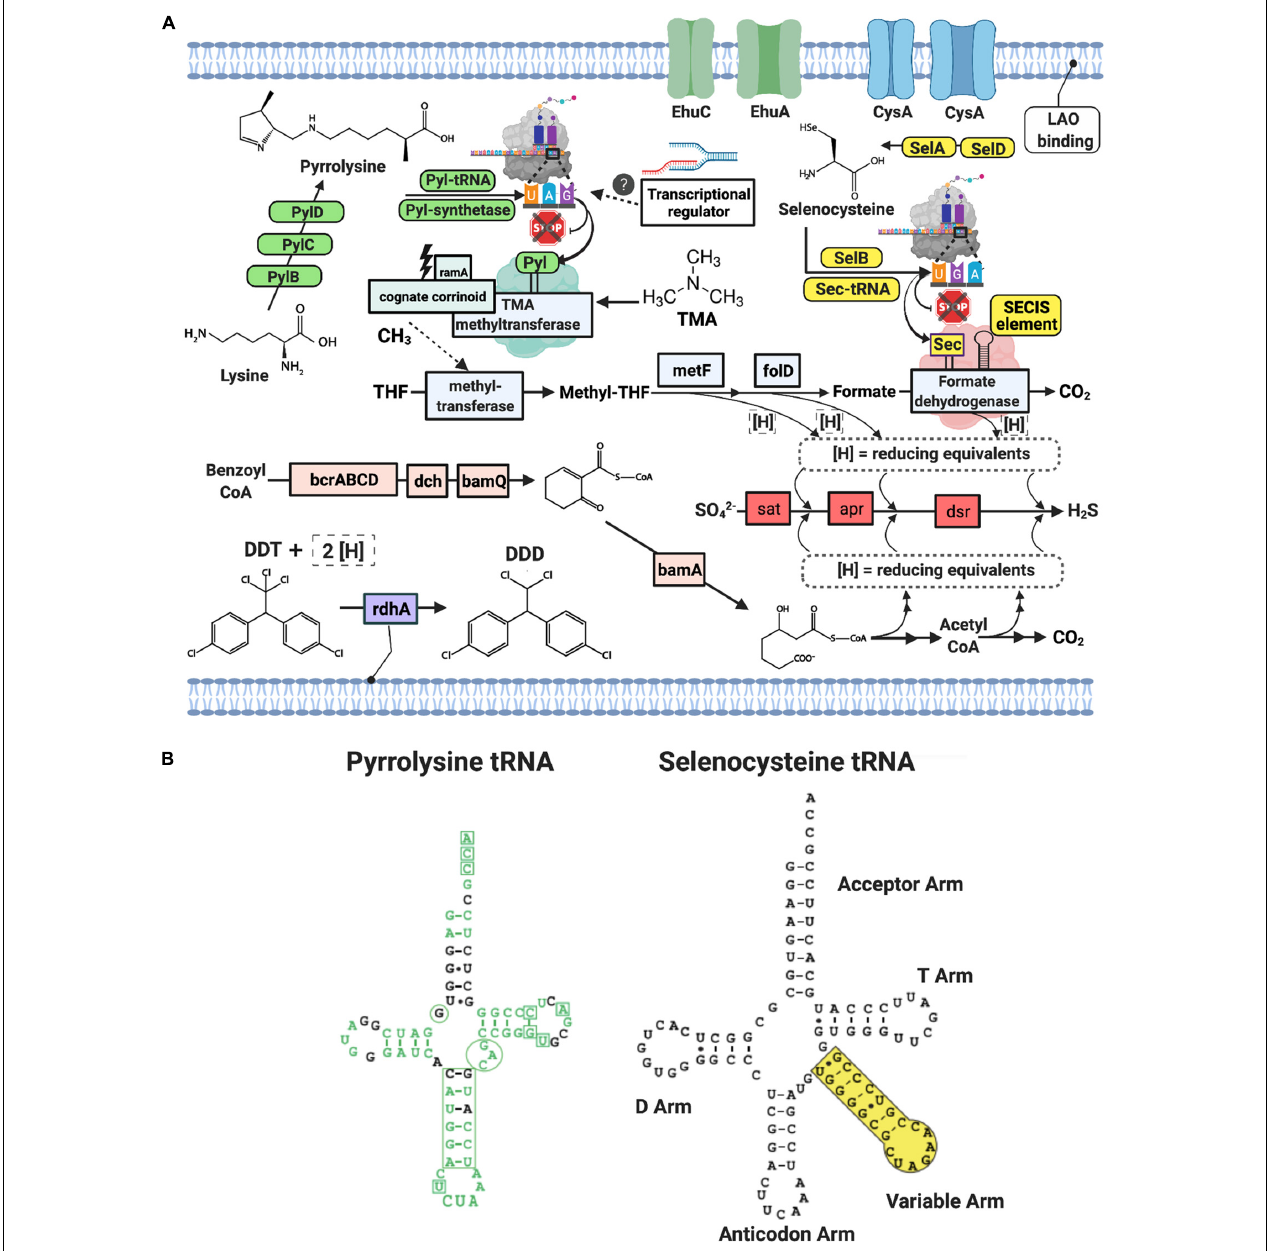
FIGURE 2 | (A) Schematic of Deltaproteobacterial-bbl cell and metabolic potential with green and yellow icons indicating machinery necessary for genetic code expansion for Pyl and Sec, respectively. Blue icons indicate proteins in the Wood-Ljungdahl pathway, pink icons indicate proteins in the benzoyl CoA pathway, and light purple is involved in dehalogenation. Gene and compound abbreviations: PylB, 3-methylornithine synthase; PylC, 3-methylornithine–L-lysine ligase; PylD, 3-methylornithyl-N6-L-lysine dehydrogenase; Pyl synthetase, pyrrolysyl-tRNA synthetase; Pyl tRNA, pyrrolysine transfer RNA; ramA, methylamine methyltransferase corrinoid protein reductive activase; cognate corrinoid, methyltransferase cognate corrinoid protein; SelD, selenide, water dikinase; SelA, L-seryl-tRNA(Sec) selenium transferase; SelB, selenocysteine-specific translation elongation factor, Sec-tRNA, selenocysteine transfer RNA; SECIS Element, selenocysteine insertion sequence element; EhuC, ectoine hydroxyectoine ABC transporter C; EhuA, ectoine hydroxyectoine ABC transporter A; LAO binding, lysine-arginine-ornithine binding periplasmic protein, rdhA, reductive dehalogenase; DDT, Dichlorodiphenyltrichloroethane; DDD, dichlorodiphenyldichloroethane; THF, tetrahydrofolate; metF, methylenetetrahydrofolate reductase; folD, methylene-tetrahydrofolate (CH2-THF) dehydrogenase/cyclohydrolase; bcrABCD, benzoyl CoA reductase subunits A,B,C,D; dch, dienoyl-CoA hydratase; bamQ, 6-hydroxycyclohex-1-ene-1-carbonyl-CoA dehydrogenase; bamA, 6-oxocylcohex-1-ene-1-carbonyl-CoA hydrolase; sat, sulfate adenylyltransferase; apr, adenylylsulfate reductase, dsr, dissimilatory sulfite reductase subunit alpha and beta. (B) Secondary structures of the pyrrolysine tRNA and selenocysteine tRNA from Deltaproteobacteria-bbl genomes. Green text indicates match with Methanosarcina tRNA sequence, including the corresponding CUA anticodon. Additionally, the boxes and circles show locations of highly conserved regions of the Methanosarcina pyrrolysine tRNA. Small black dots in stems indicate wobble base pairs.